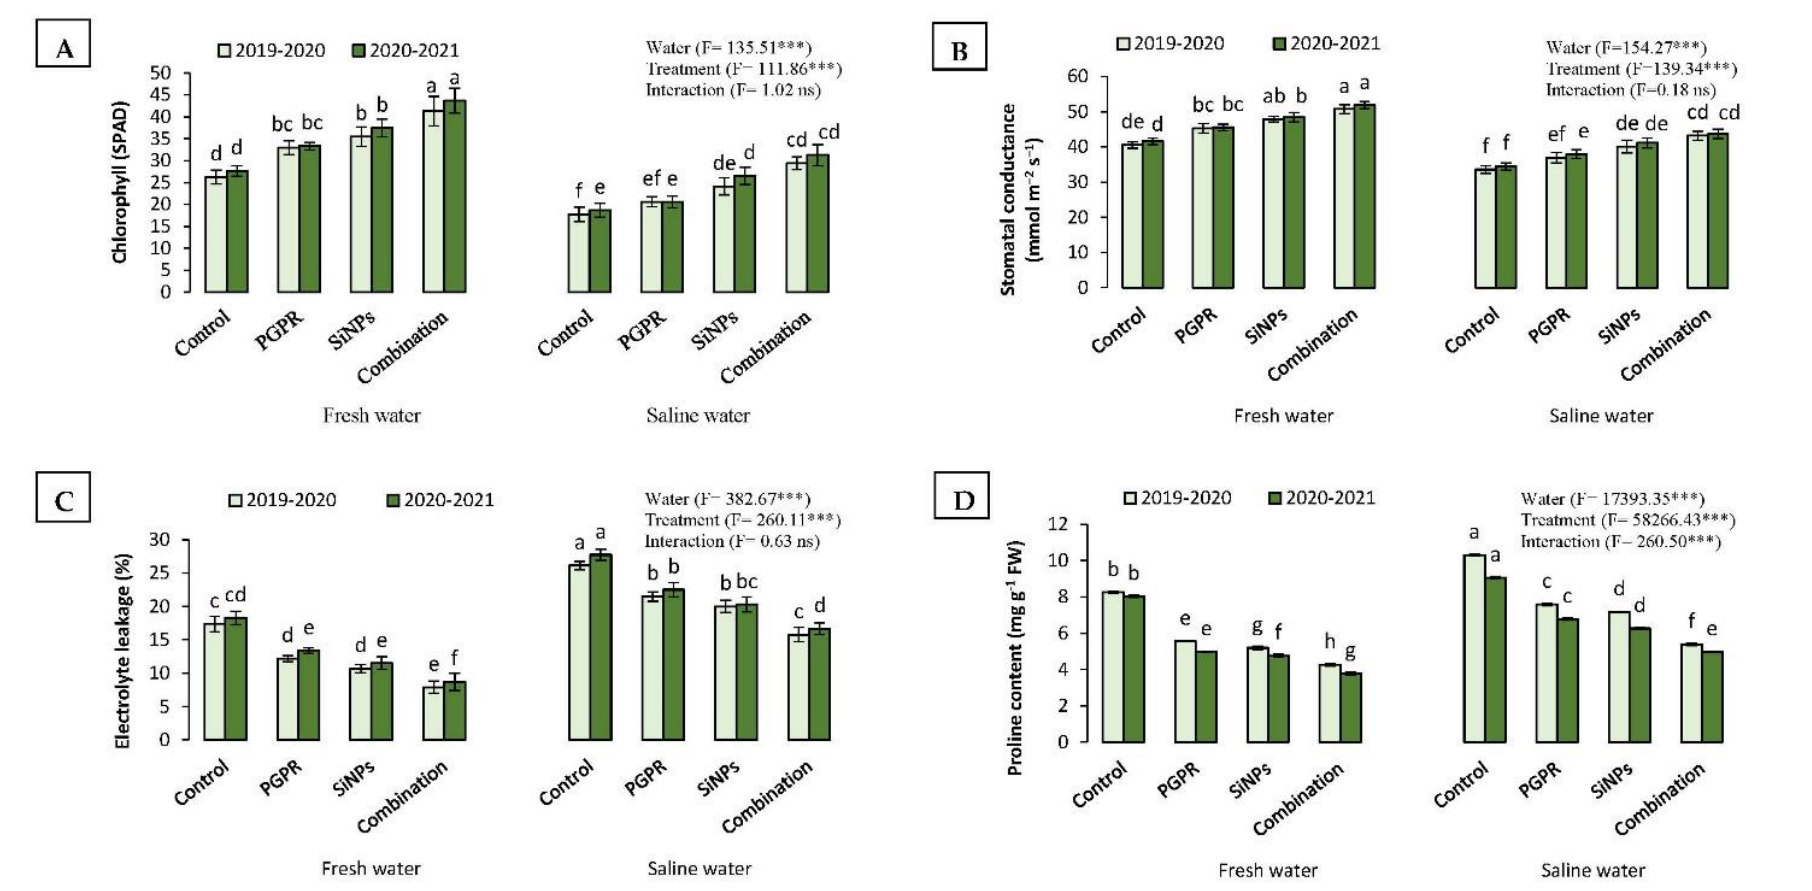
Figure 1. ( A ) Relative chlorophyll content (SPAD); ( B ) stomatal conductance; ( C ) electrolyte leakage; and ( D ) proline content of barley ( Hordum vulgare L., cv. Giza 132), which was cultivated in salt-affected soil and treated with plant growth-promoting rhizobacteria (PGPR; Azotobacter chroococcum SARS 10 and Pseudomonas koreensis MG209738), silica nanoparticles (SiNPs), and their combination to alleviate the detrimental impacts of saline irrigation water during two consecutive seasons. Different letters on the same columns of the same season are significant according to the Tukey’s test ( p ≤ 0.05). Two-way ANOVA was run to display the significant differences between types of irrigation water, treatments, and their interaction according to the Tukey’s test ( p ≤ 0.05). Data are the means ± SD and n = 3. *** denotes significance at P ≤ 0.001, ns denotes insignificant differe nce.